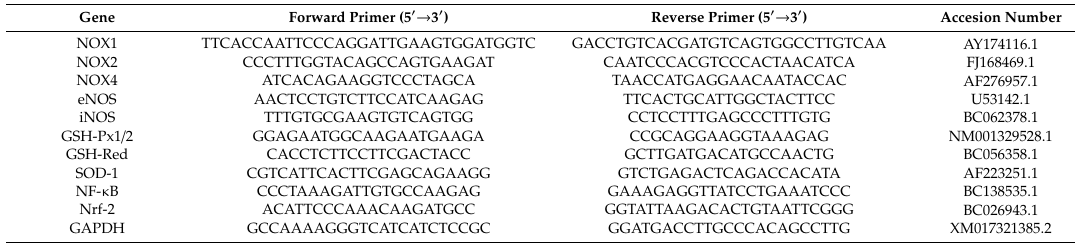
Table 4. Primers used for real-time